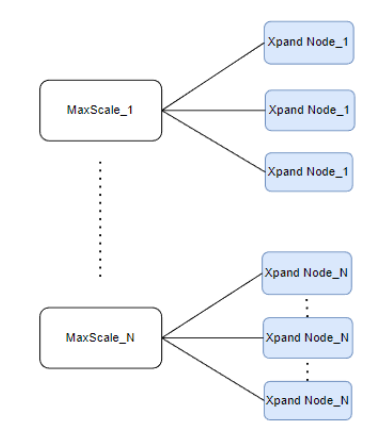
Figure 3. Xpand Performance Topology.